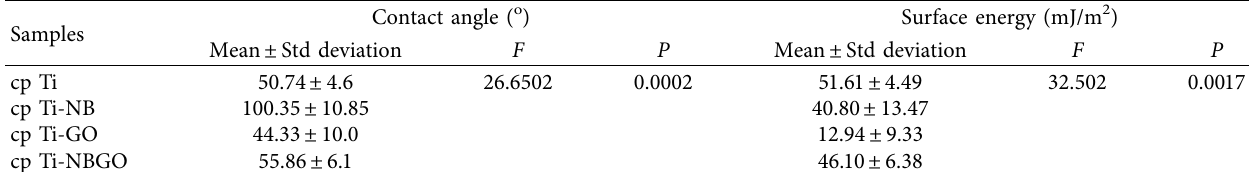
Table 2: Contact angle, surface energy, and statistical data.